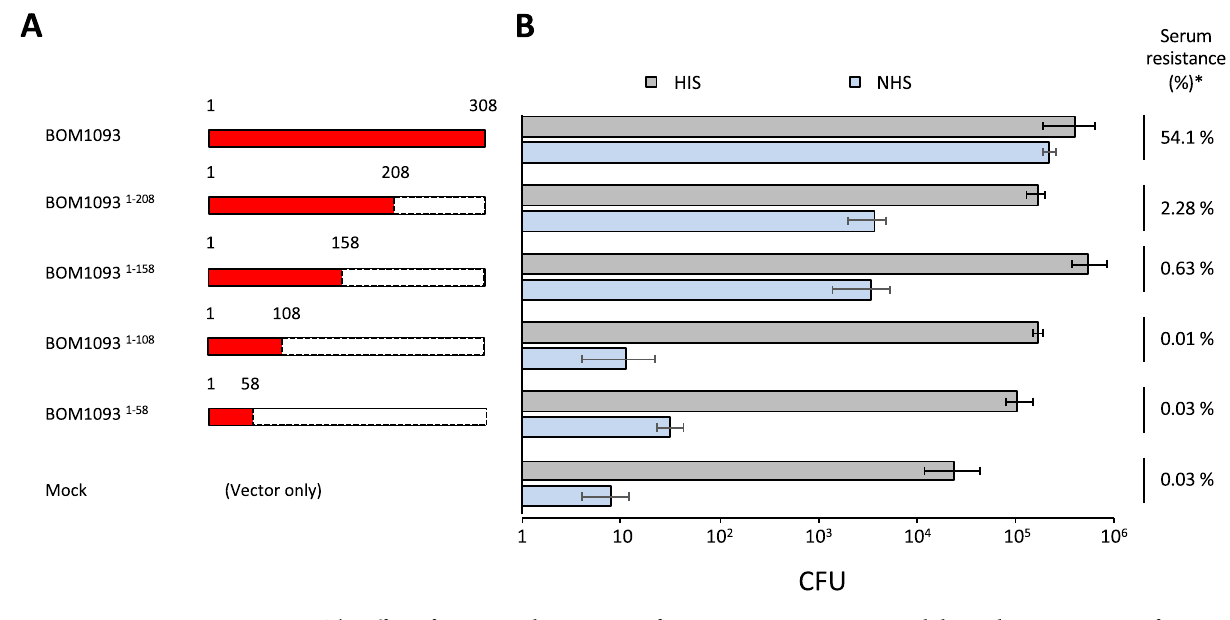
Figure 6. The effect of C-terminal truncation of BOM1093 on serum susceptibility. Schematic picture of C-terminal truncation of BOM1093 (left) and serum susceptibility of each mutant (right) are shown. *Ratio of serum resistance (%) was calculated by dividing the CFUs of NHS by CFUs of HIS, respectively.